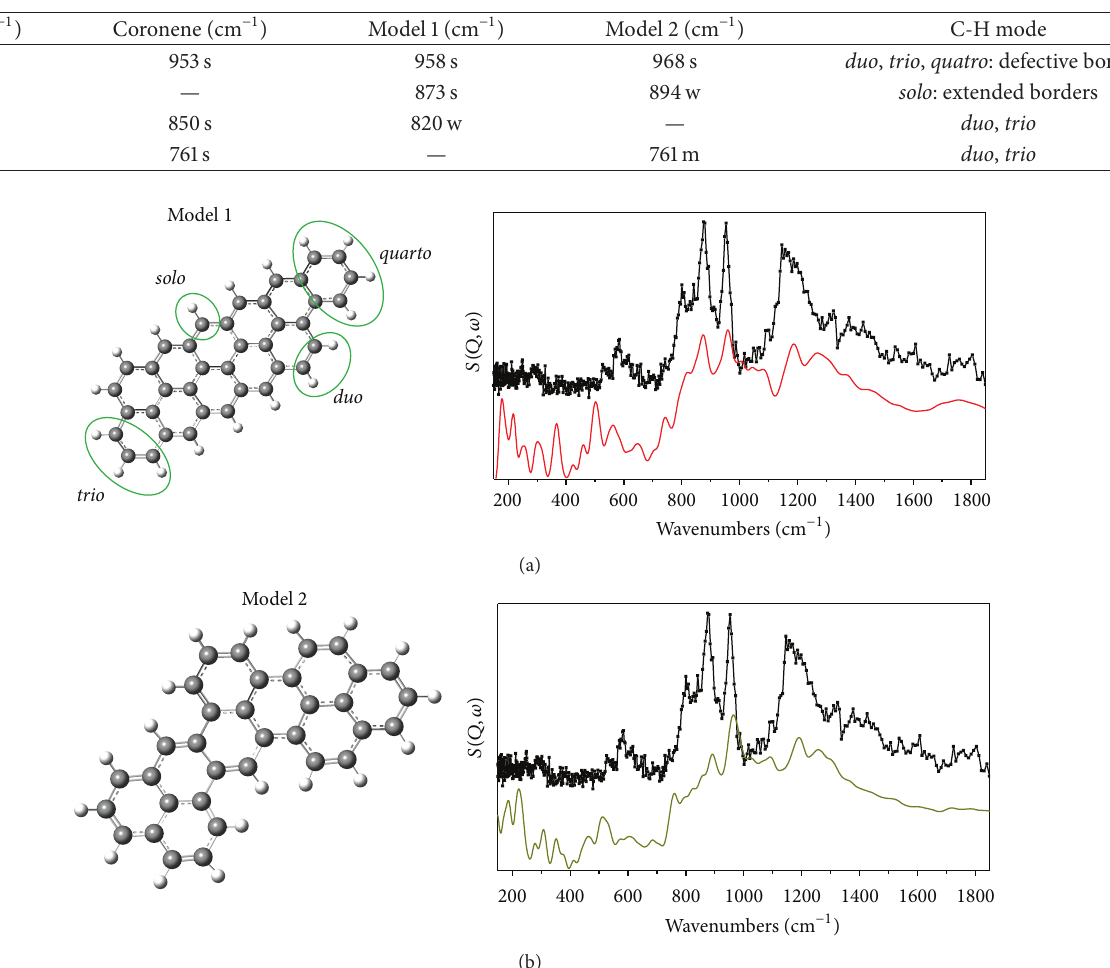
Figure 2: Two different model clusters used to represent surface C-H species present on activated carbons. Each model has a different proportion of C-H solo : duo : trio : quatro , defined as evidenced in green circles. Independently of the model, the mode at 950 cm −1 is always intense, while the modes at lower frequencies (905, 880, 820, and 760 cm −1 ) depend on the proportion of the different species present. The calculated spectra (full curves, vertically shifted for clarity) are compared to the experimental INS spectrum of CW (dotted